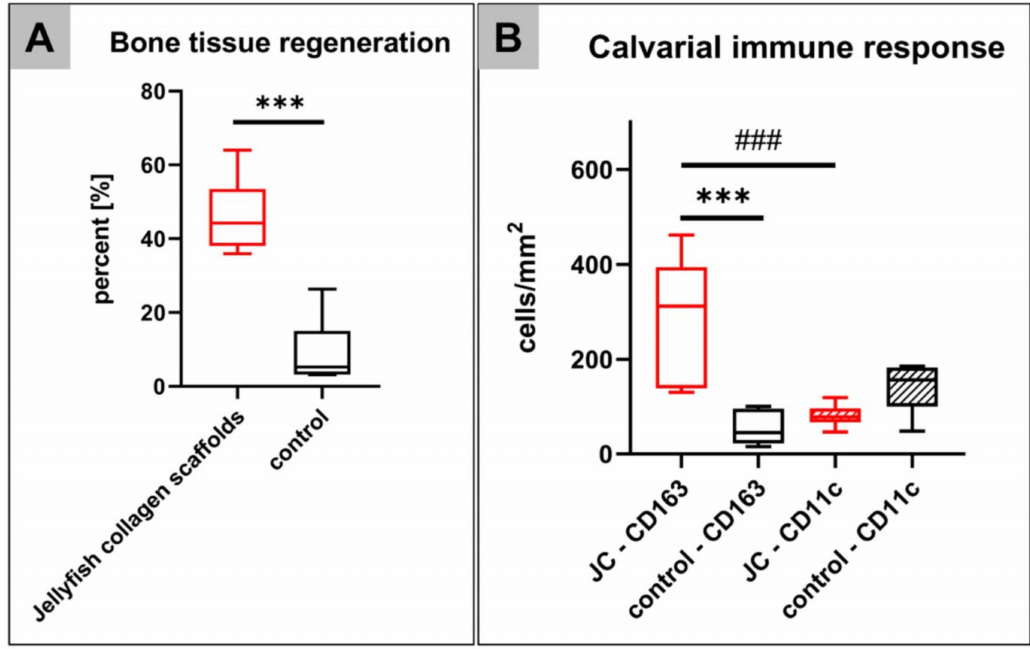
Figure 10. Results of the histomorphometrical analysis of ( A ) the bony regeneration and ( B ) the occurrence of CD163- and CD11c-positive macrophages within the cavarial bone defects (* = interindividual significances, # = intraindividual